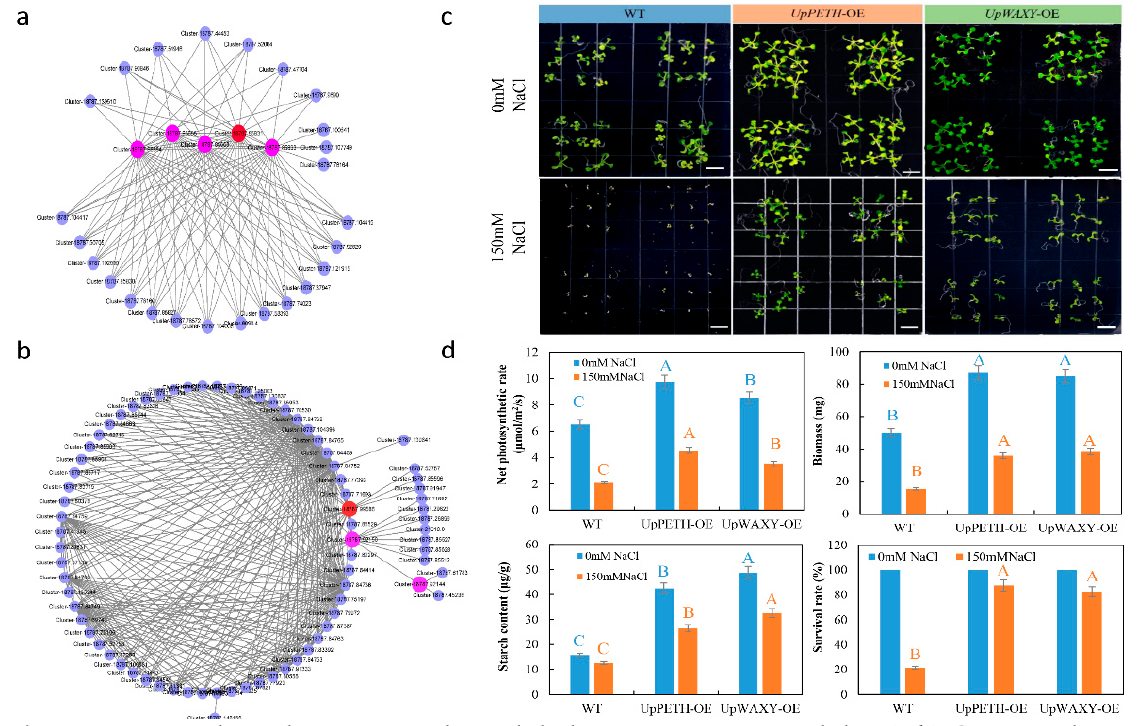
Figure 7. Potential regulatory networks with hub genes in target modules. ( a , b ) Gene regulatory network with potential interactions with ( a ) UpPETH (Cluster-18787.85831), and ( b ) UpWAXY (Cluster-18787.99586), respectively. Red nodes represent hub genes (UpPETH or UpWAXY), pink nodes represent genes homologous with the hub gene, and blue nodes represent genes with potential interactions with the hub gene. Details of gene annotation are provided in Tables S15 and S16. ( c ) Phenotypes of transgenic and WT Arabidopsis lines with UpPETH and UpWAXY overexpression after 7 days of growth under 0 mM and 150 mM NaCl treatments; ( d ) Pn, biomass, starch content, and survival rates of transgenic plants after 45 days of growth under 0 mM and 150 mM NaCl treatments. Values represent means ± SD (n = 3). Bars with blue uppercase letters indicate statistical significance at P <0.01 under the 0 mM treatment. Bars with orange uppercase letters indicate statistical significance at p < 0.01 under the 150 mM treatment.